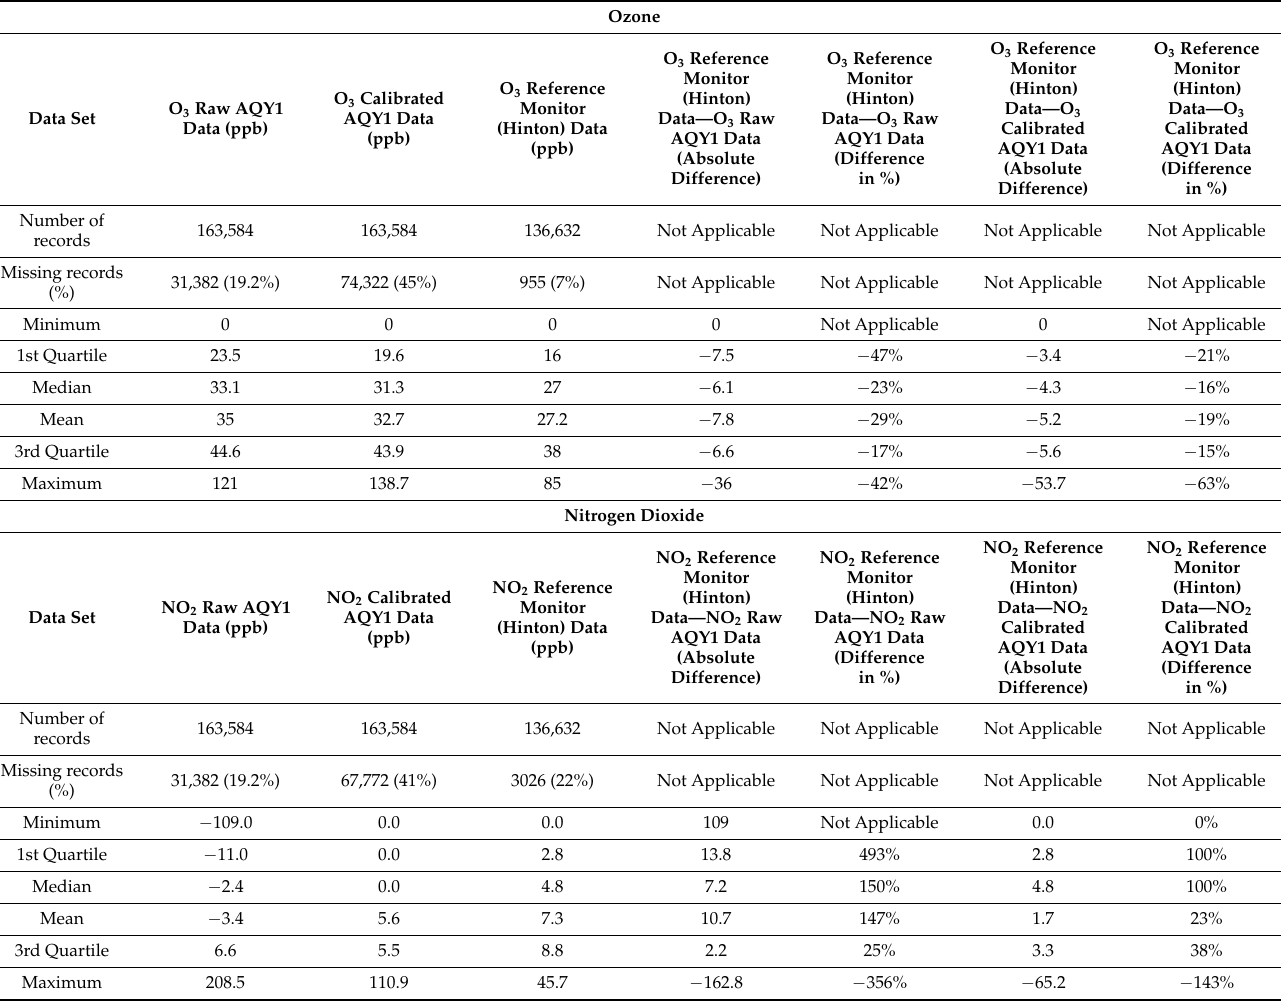
Table 2. Descriptive (Summary) Statistics Comparison Between the AQY1 Monitors and the Reference (Hinton) Monitor. Results by Device ID may be more